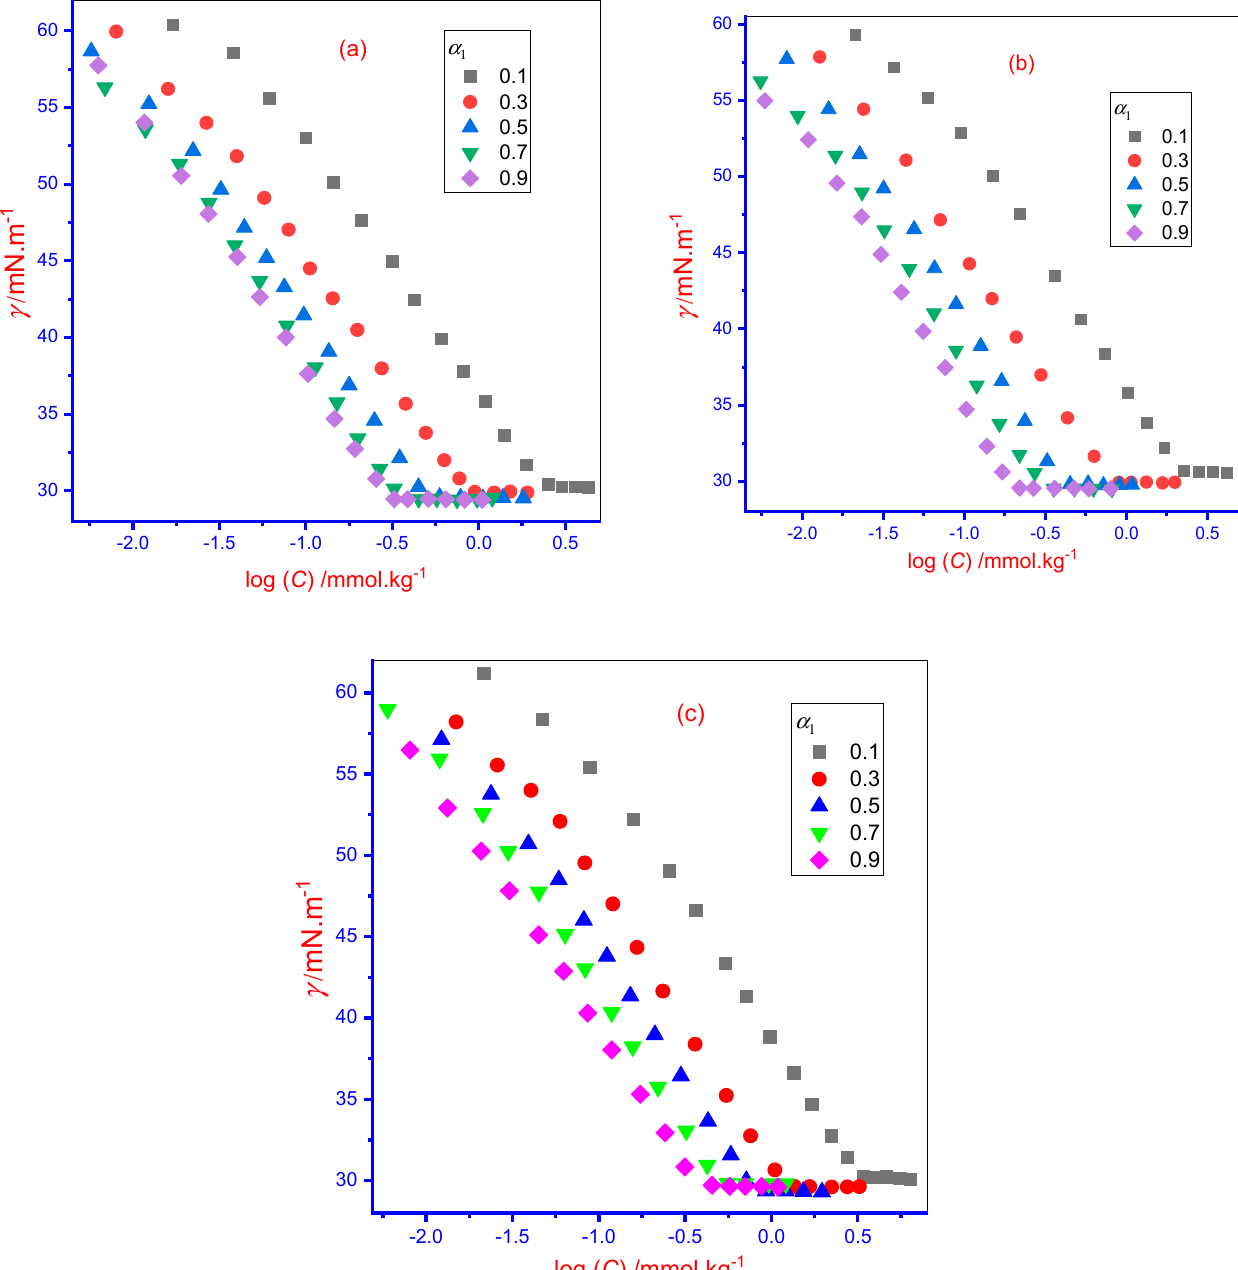
Figure 2. Graph of surface tension ( γ ) against concentration ( C ) plot for the IMP + TX-100 mixture in various mole fraction ( α 1 ) of TX-100 in ( a ) aqueous, ( b ) 0.050 mol · kg − 1 aqueous NaCl, and ( c ) 0.250 mol · kg − 1 aqueous U media.